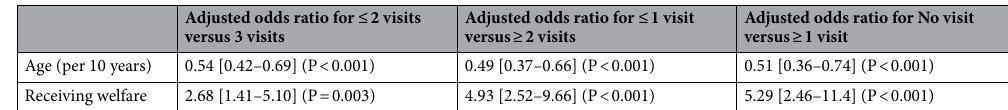
Table 6. Adjusted association of clinical characteristics with lower frequency of hospital visitation by a trusted family member or friend in the overall study population ( n = 413). Data are adjusted odds ratios [95% confidence intervals] (P values), derived from the multivariable logistic regression analysis. The multivariable logistic regression model included all the variables in the table, which had a statistically significant crude association, and simultaneously had an absolute value of Spearman’s correlation coefficient of larger than 0.2 (see Table 4).